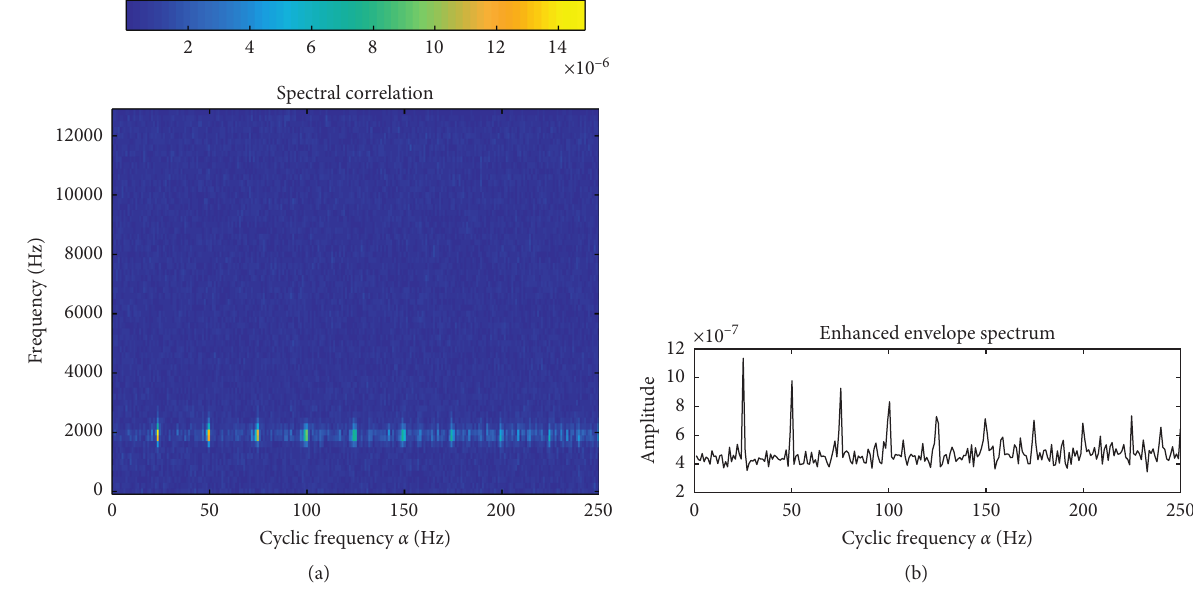
Figure 4: FSC image and EES of the reconstructed signal: (a) FSC image of the reconstructed signal by using the learned atoms as shown in Figure 3; (b) EES image of the reconstructed signal by using the obtained FSC image as shown in Figure 4(a).